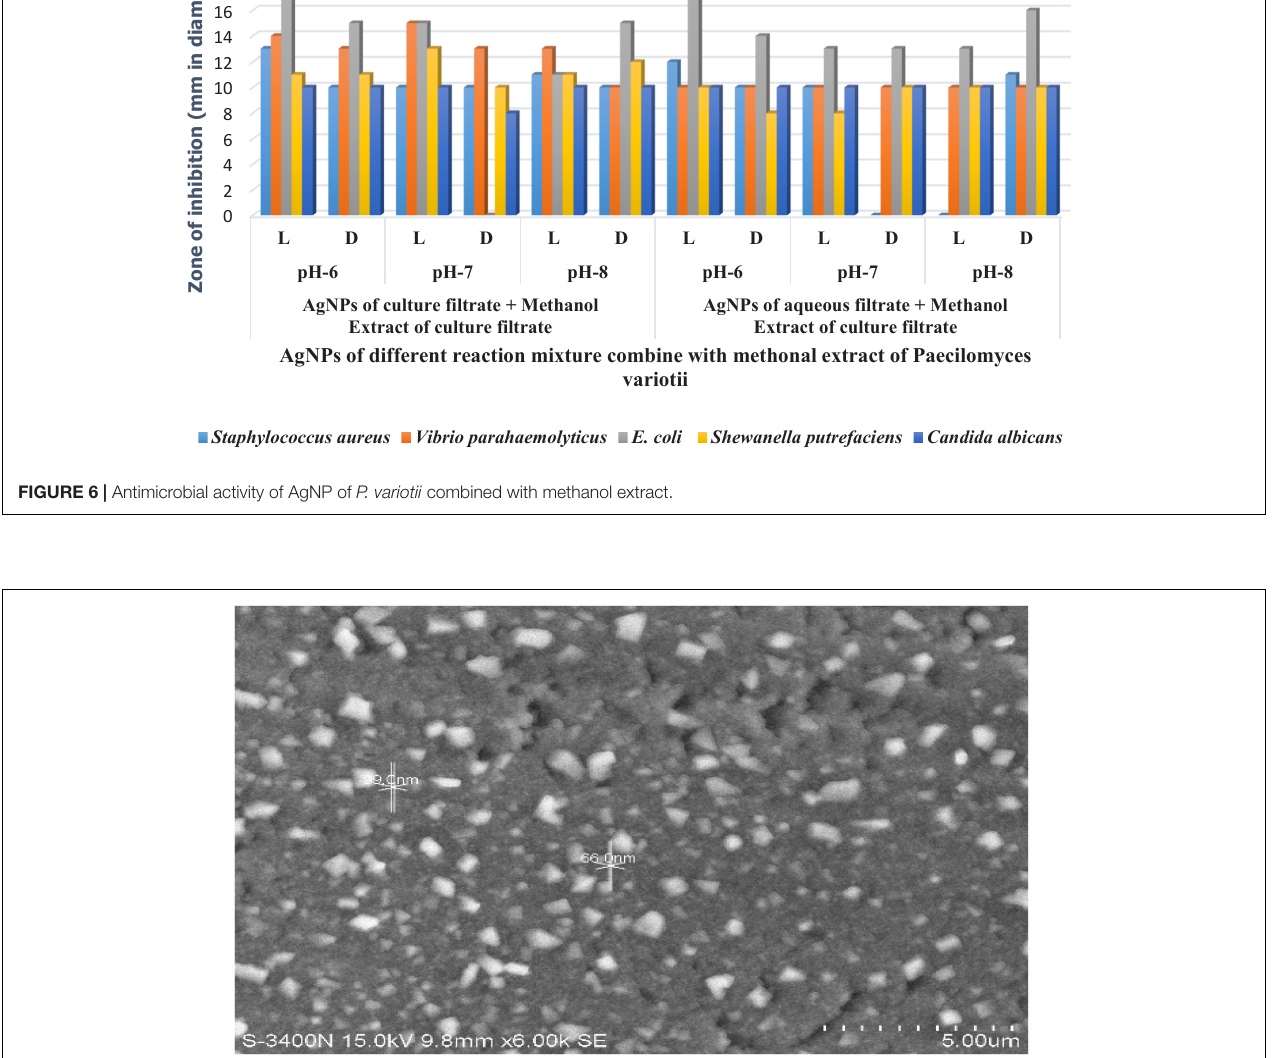
Frontiers in Microbiology |